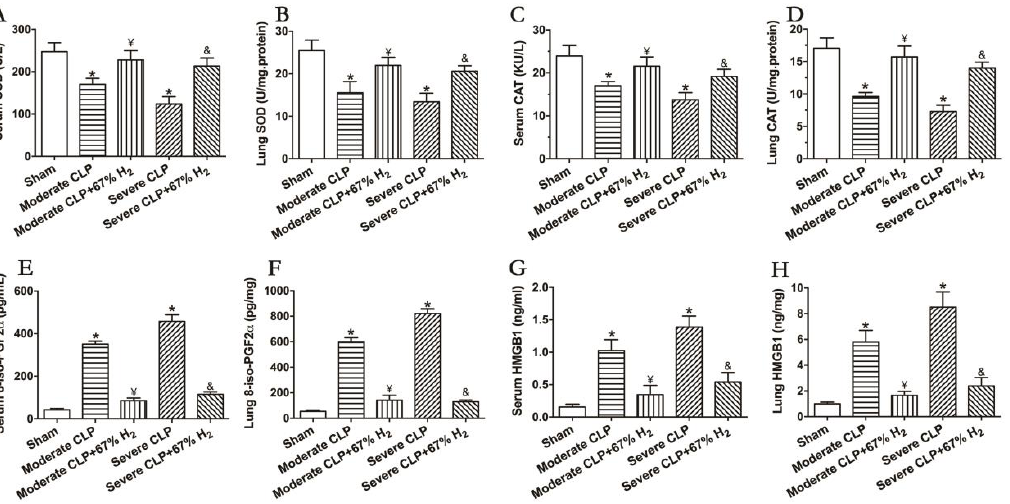
Figure 3. 67% H 2 inhalation improved the activities of SOD and CAT, and down-regulated levels of 8-iso- PGF2α HMGB1 and HMGB1. ( A , B ) Serum and lung SOD activity; ( C , D ) Serum and lung CAT activity; ( E , F ) Serum and lung 8-iso- PGF2α level; ( G , H ) Serum and lung HMGB1 level. The blood and lungs were sampled for testing these indicators at 24 h after CLP or sham operation. All the data were expressed by mean ±SEM ( n = 6 per group). * p < 0.05 vs. Sham group. ¥ p < 0.05 vs. Moderate CLP group. & p < 0.05 vs. Severe CLP group.